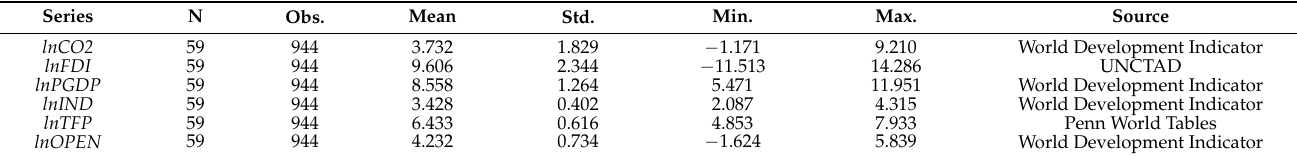
Table 2. Property of the